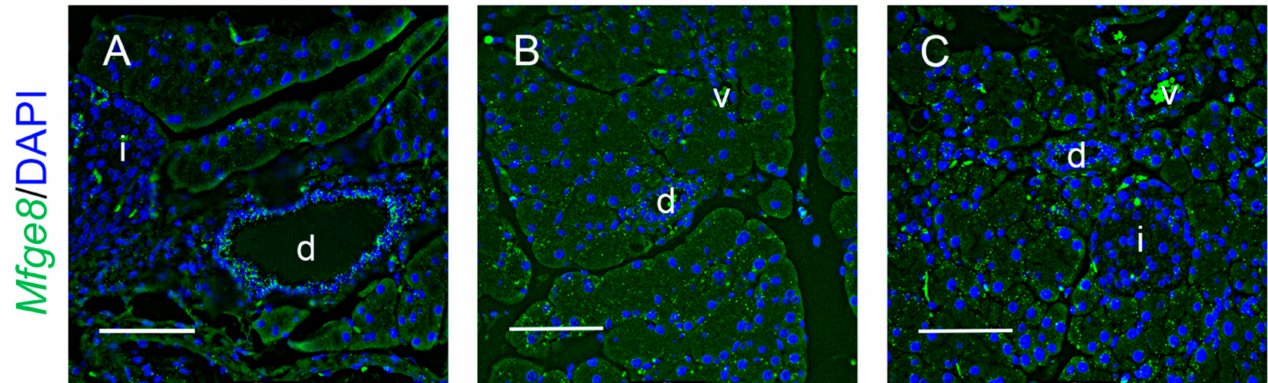
Figure 2. Cellular localization of Mfge8 transcripts in the pancreas of mice with acute pancreatitis using RNAscope fluorescent in situ hybridization assay. Young adult C57BL/6J mice (male, 8–10 weeks old) were subjected to cerulein treatment for induction of acute pancreatitis as described in Figure 1. Pancreatic tissue was fixed with 10% formalin and processed for routine histology. Sections of pancreas were stained using the RNAscope ® Fluorescent Assay with a probe for Mfge8 transcripts (green) followed by counterstaining with DAPI (blue). Representative fluorescent microscopy images show the localization of Mfge8 transcripts in pancreas of mice in the sham-treated group ( A ), 24 h post-cerulein injection ( B ), and 48 h post-cerulein injection ( C ); d indicates ducts; v, blood vessels; and i, islets in the pancreatic lobules. Scale bar: 50 µ